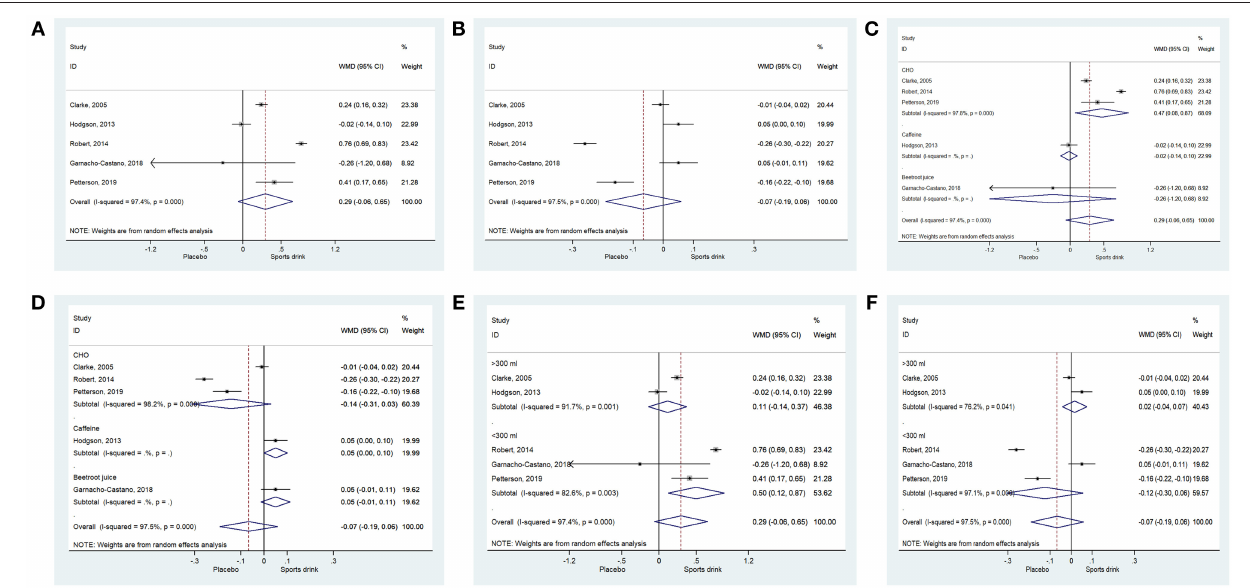
FIGURE 2 | (A) Forest plot of CHO oxidation; (B) forest plot of fat oxidation; (C) forest plot of subgroup carbohydrate oxidation; (D) forest plot of subgroup fat oxidation; (E) forest plot of sports drink amount on CHO oxidation; (F) forest plot of sports drink amount on fat oxidation.